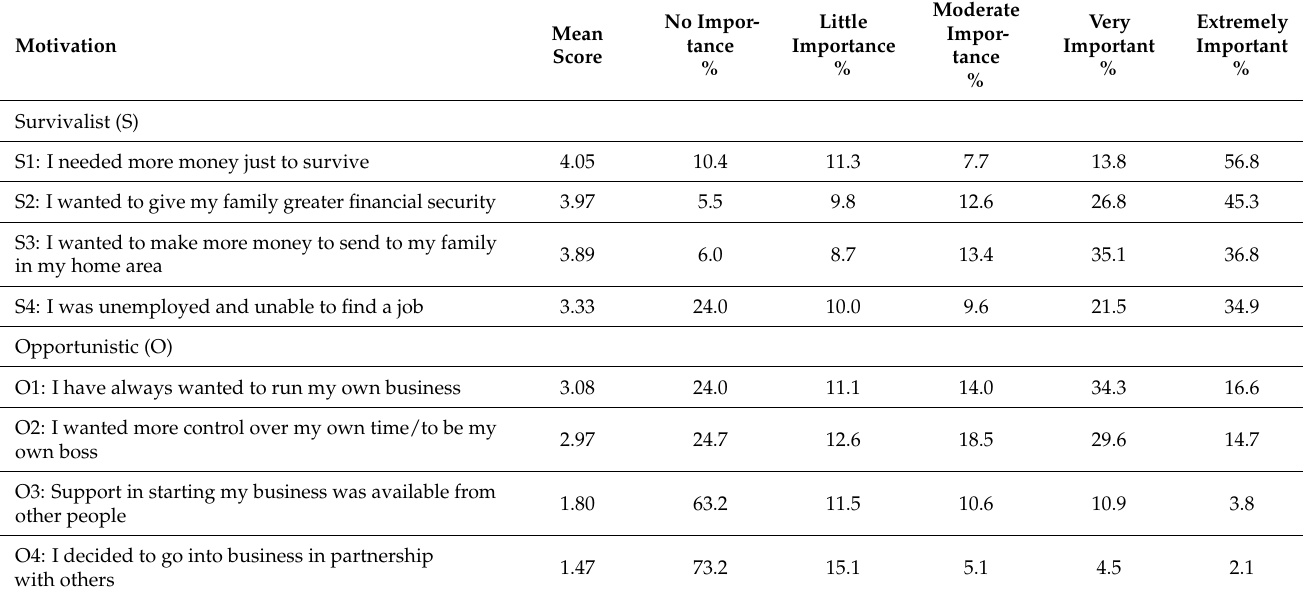
Table 5. Motivation for starting an informal food